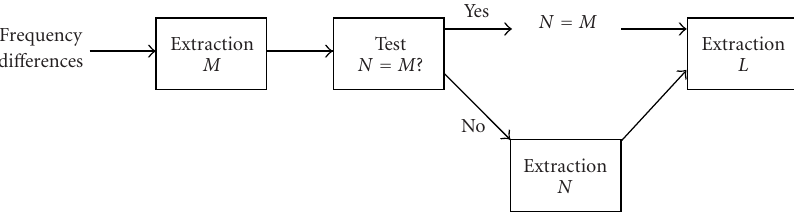
Figure 3: Principle of the analysis of the statistical parameters of the